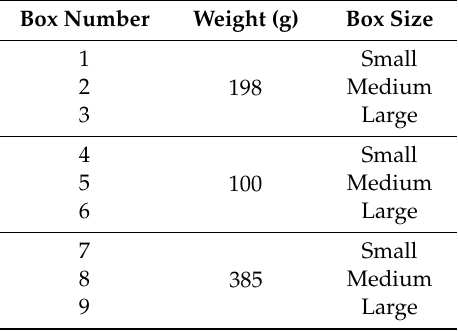
Table 2. Size and weight of cookie